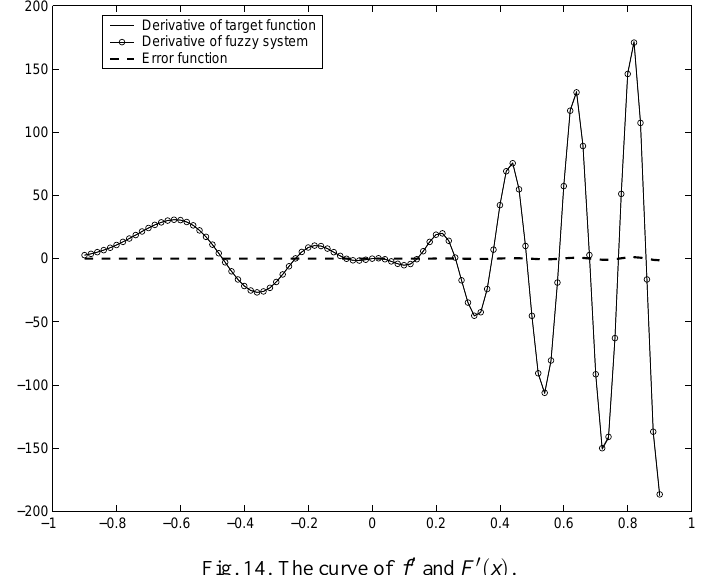
Fig. 13. The curve of target function f ( x ) and fuzzy system F ( x ) .